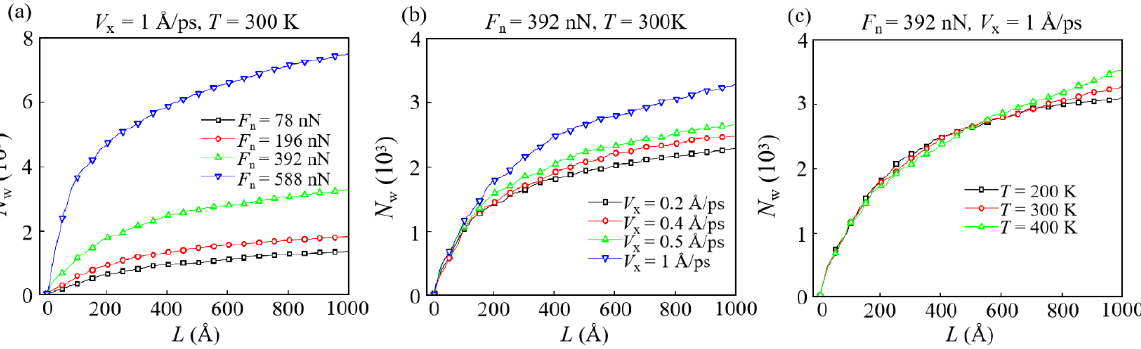
Figure 6. The evolution of the number of worn atoms N w with different conditions: ( a ) V x = 1 Å/ps, T = 300 K; ( b ) F n = 392 nN, T = 300 K; ( c ) F n = 392 nN, V x = 1 Å/ps.